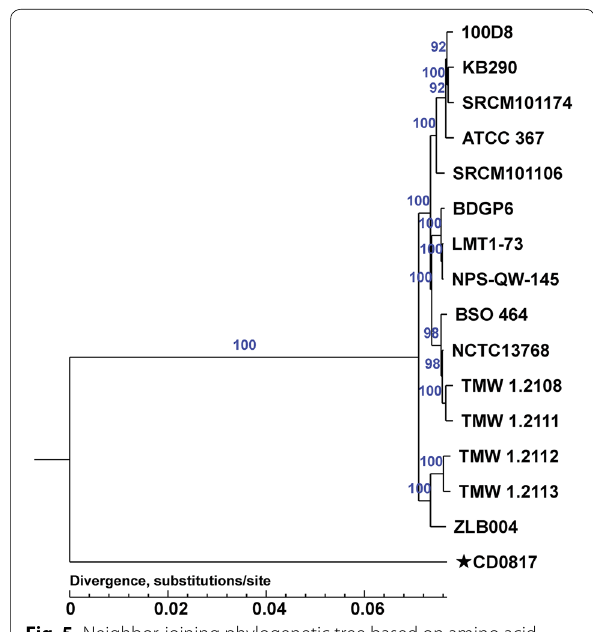
Fig. 5 Neighbor-joining phylogenetic tree based on amino acid sequences of 718 single-copy orthologous genes detected from gene family analysis of CD0817 and 15 completely sequenced reference Lactobacillus brevis strains. Bootstrap values higher than 70% are shown at branch